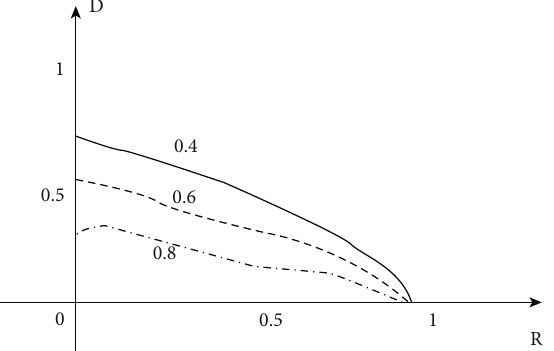
Figure 6: Relationship between the weight value and the influence on the successive vowels.